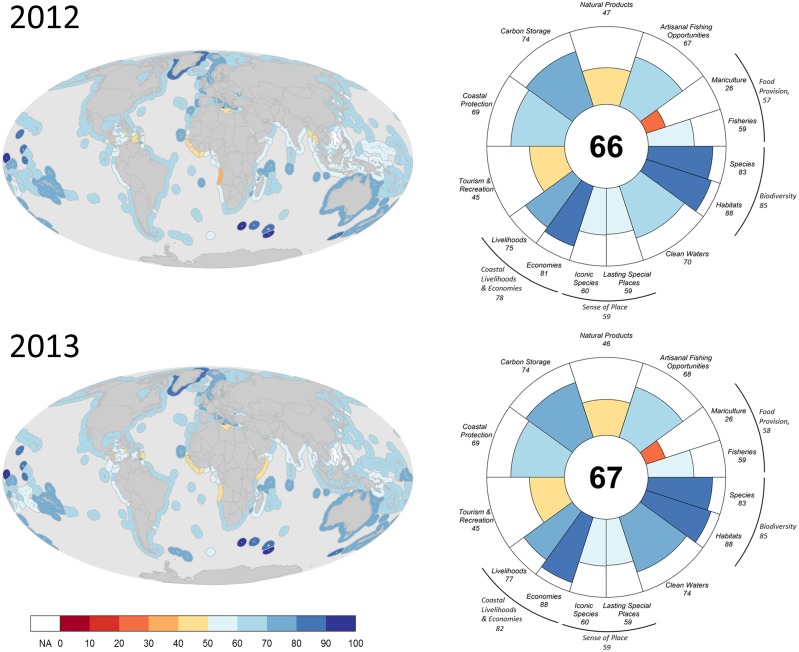
Global scores for the Ocean Health Index.Maps of overall Index scores for each reporting region (left panels) and global Index and goal scores (right panels) for newly calculated 2013 values (bottom panels) and recalculated 2012 values using updated methods and data (top panels). Colors in all cases indicate score values.